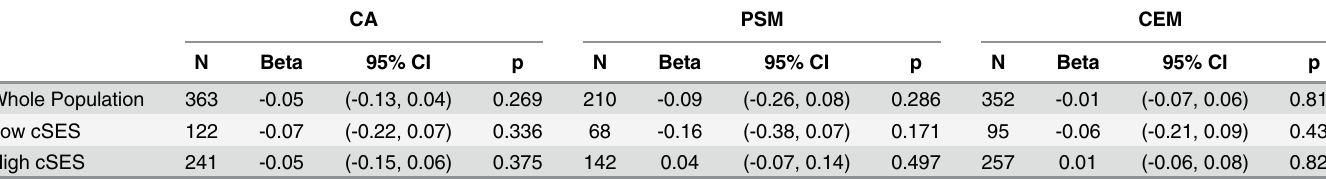
Table 9. Results from CA, PSM, and CEM methodologies for elevated depressive symptoms. CA PSM